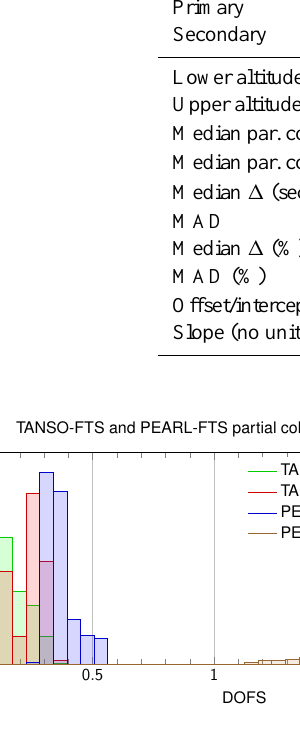
Figure 15. Information content (DOFS) for partial columns. Each histogram shows DOFS for a data set collocated with another data set; for example, one of the PEARL-FTS histograms shows DOFS for PEARL-FTS partial columns collocated with TANSO- FTS, whereas the other PEARL-FTS histogram shows DOFS for PEARL-FTS partial columns collocated with ACE-FTS. The his- tograms are normalized such that the total area for each histogram equals